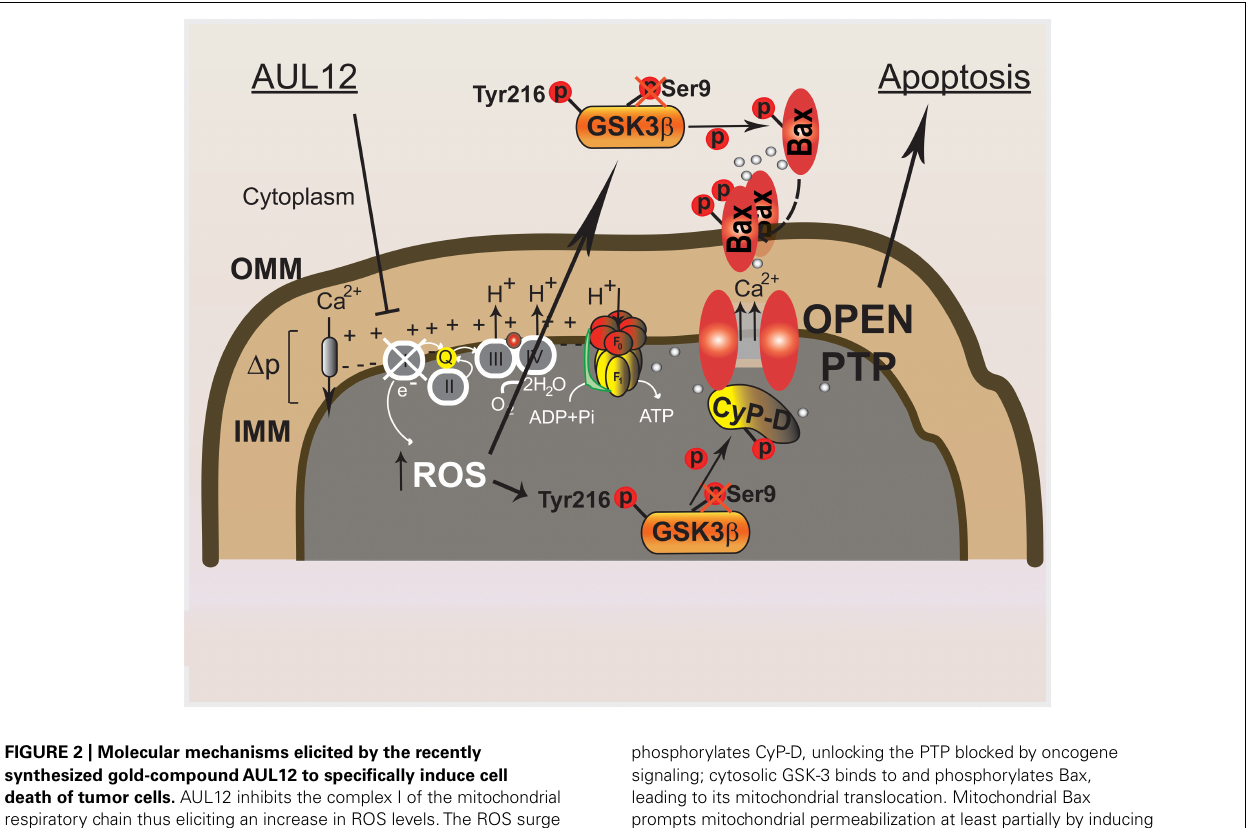
FIGURE 2 | Molecular mechanisms elicited by the recently synthesized gold-compoundAUL12 to specifically induce cell death of tumor cells. AUL12 inhibits the complex I of the mitochondrial respiratory chain thus eliciting an increase in ROS levels.The ROS surge reactivates the oncogenically inhibited GSK-3; mitochondrial